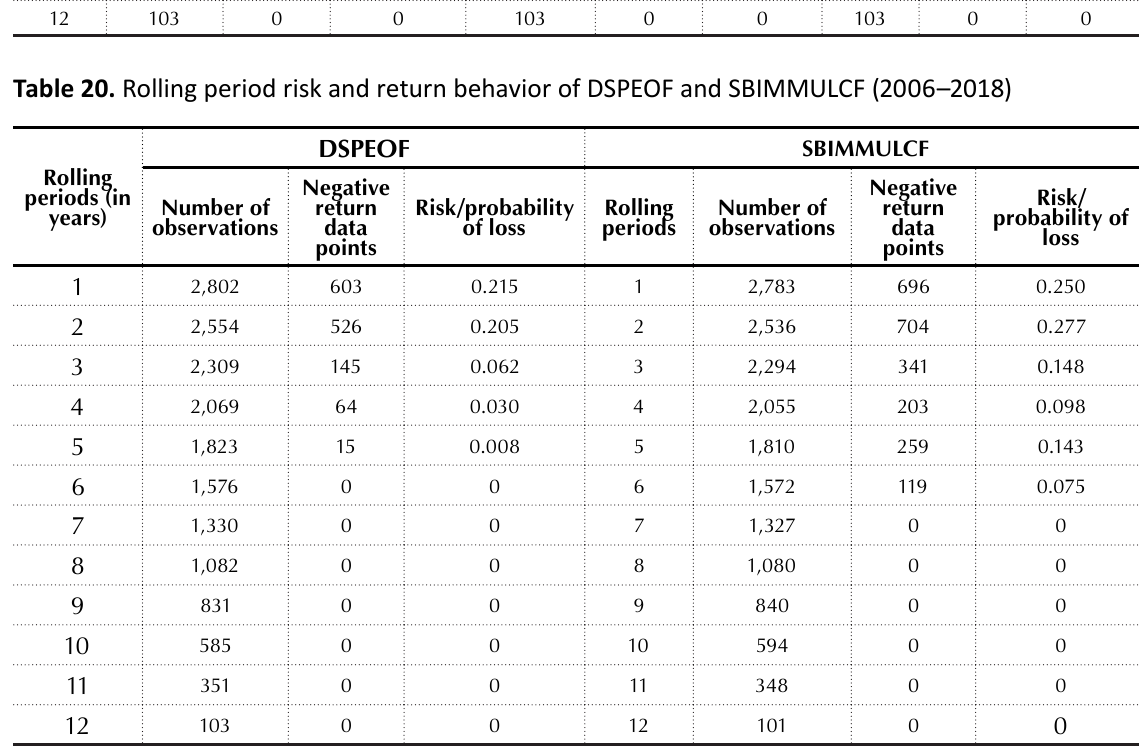
Table 21. Rolling period risk and return behavior of SENSEX and Nifty